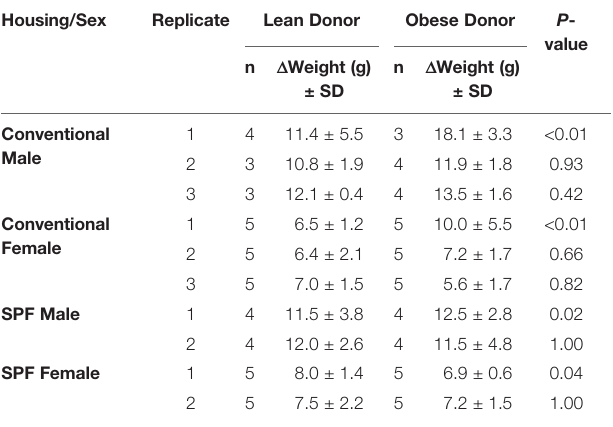
TABLE 1 | Change in total body weight (g) from baseline to 10-weeks